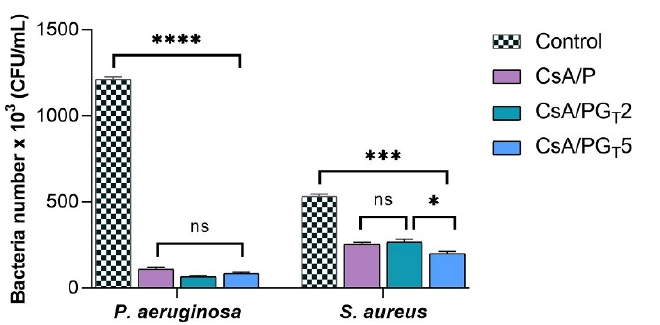
Figure 9. Evaluation of anti-biofilm activity of the nanofibrous membranes against P. aeruginosa (ns p < 0.5, **** p < 0.0001) and S. aureus (ns p < 0.5, * p < 0.05, *** p < 0.0005).